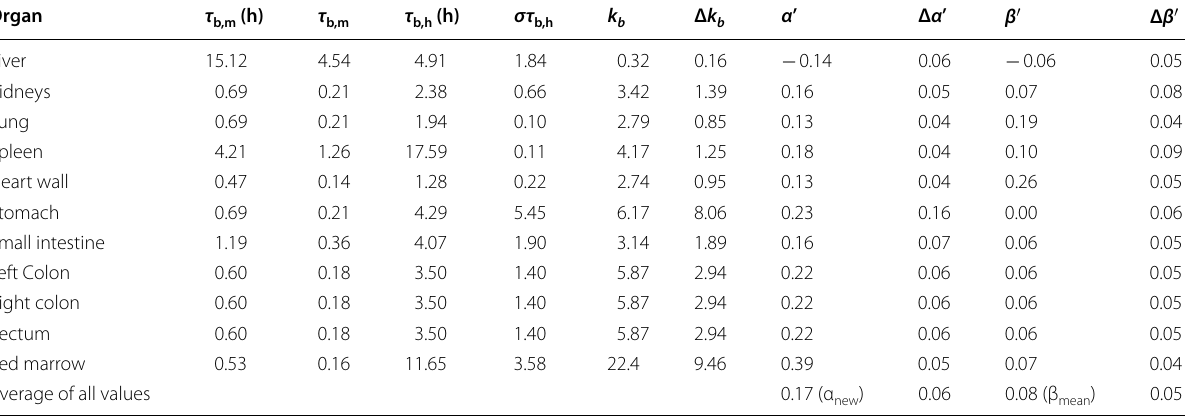
Table 4 Organ-specific allometric parameters, and corresponding uncertainties, calculated using combined experimental [ 68 Ga]